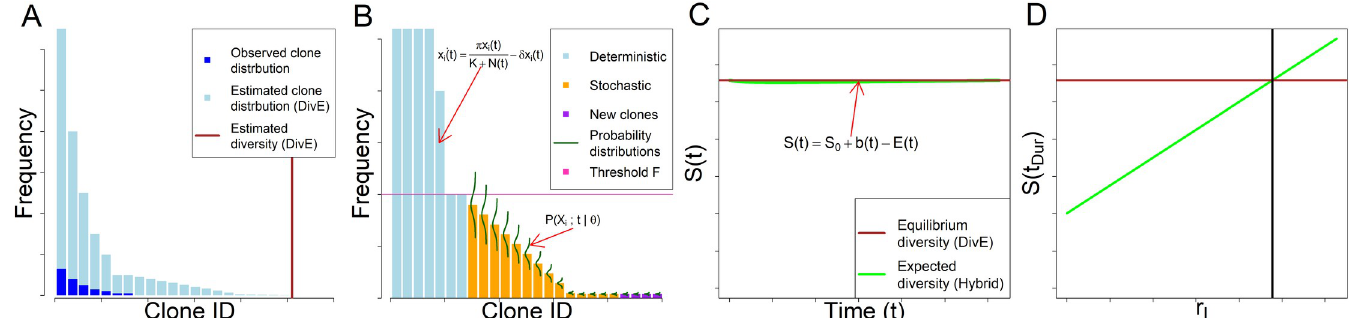
Fig 2. Schematic of full simulation hybrid model. A : Observed and estimated clone frequency distributions. From an observed sample of clones, the clone frequency distribution of the body in one host is estimated using DivE. B : Propagation of hybrid model: Estimated clone frequency distribution partitioned into deterministic and stochastic systems. Clones of frequency less than and greater than threshold F are respectively modelled stochastically and deterministically. F is chosen with respect to probability of clone extinction (S2 Text). The deterministic system is modelled using ordinary differential equations (Eq (1)). The stochastic system consists of multiple birth-death processes (one for each stochastically modelled clone) each with an absorbing state at zero (Fig 3A and 3B). The evolution of the clone probability distribution over time is governed by the chemical master equation (Eq (10), Fig 3C and 3D). New clones are created through infectious spread, i.e. the per-capita rate r I multiplied by the expected number of infected cells, in both deterministic and stochastic compartments (Eq (11)). Deterministic and stochastic systems are propagated concurrently with Strang splitting (S2 Text). C : Hybrid model diversity. The estimated number of clones S(t) (Eq (13)) at time t , given parameters θ = {π , δ , K , r I } is given by the number of clones created (Eq (11)), minus the number of clones that are expected to have died between 0 and t (Eq (12)), plus the number of clones S The number of clones is assumed to be at equilibrium in the chronic phase of infection. D : Model fitting schematic: Expected diversity at S(t Dur ) increases with per- . Model fitted using non-linear least squares to DivE estimated diversity in the body, where the objective function is the square of the capita infectious spread rate r I discrepancy between this value and the value of S(t Dur ) at equilibrium.